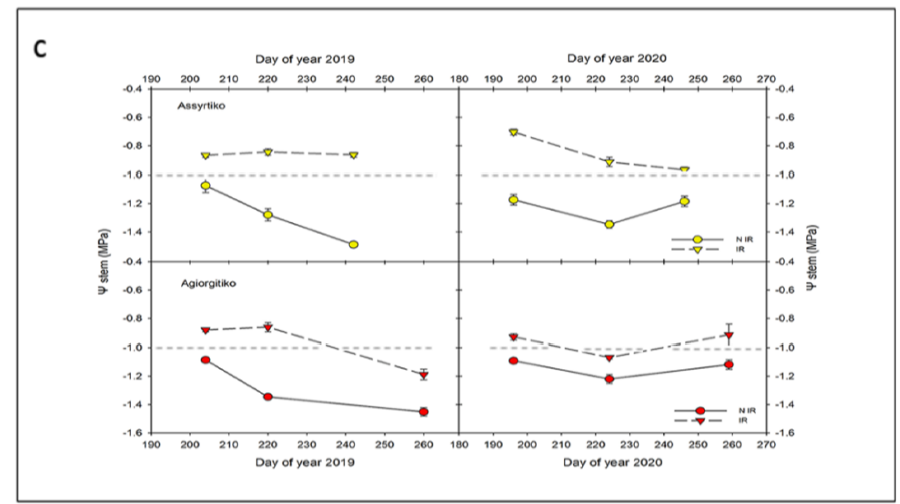
Figure 1. Weather conditions at the experimental vineyards and vine water status ( A ). Evolution of monthly maximum temperature and total rainfall from March to October during the seasons 2019 and 2020; left panel: Drama (Assyrtiko—yellow bar), right panel: Kavala (Agiorgitiko—red bar), blue line: 2019, green line: 2020 ( B ). Evolution of daily maximum temperature during the summer months of 2019 and 2020; upper panel: Drama (Assyrtiko—yellow line), lower panel: Kavala (Agiorgitiko—red line). Black arrows indicate the days of sampling and blue arrows the period of veraison ( C ). Stem water potential ( Ψ stem) during ripening. Vertical bars indicate the standard deviation of mean values. IR, irrigated; NIR, non-irrigated.